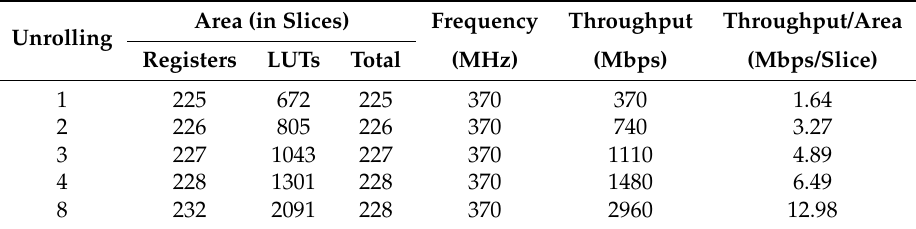
Table 4. MICKEY 2.0 synthesis results (Xilinx Spartan6, device XC6SLX45).